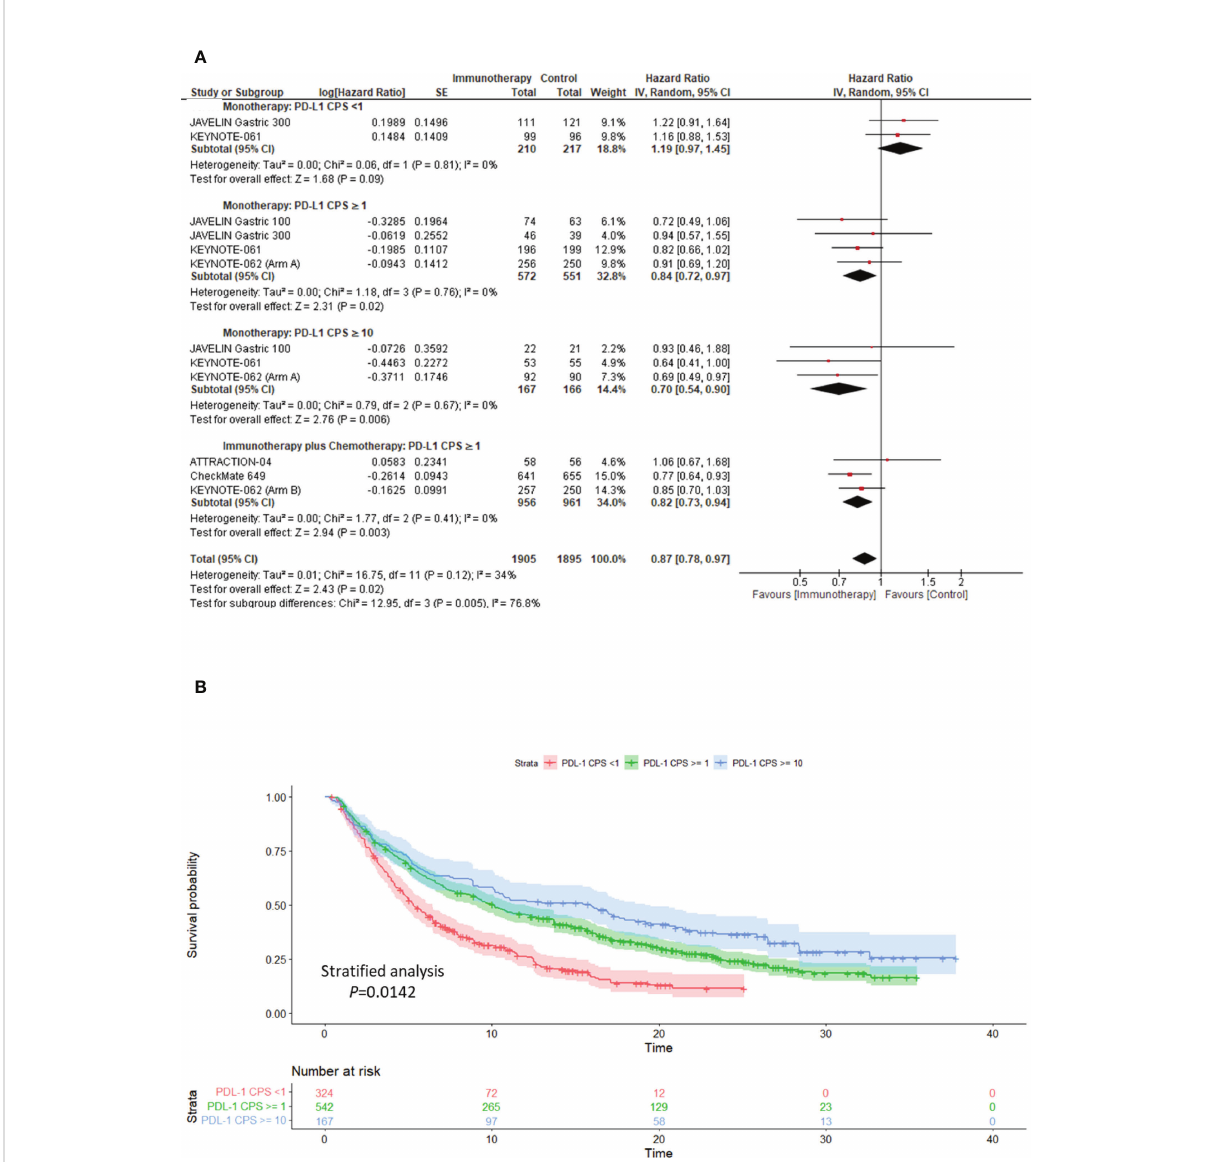
FIGURE 3 Clinical utility of PD-L1 as a biomarker for response to ICIs in advanced gastric cancer. (A) sensitivity analysis forest plot to demonstrate the impact of PD-L1 CPS on Overall Survival following treatment immunotherapy either as monotherapy or in combination with the comparator. (B) Kaplan – Meier overall survival curve illustrating the clinical relevance of PD-L1 in determining response to single-agent immunotherapy. PD- L1, programmed cell death ligand-1; CPS, combined positive score; CI, con fi dence